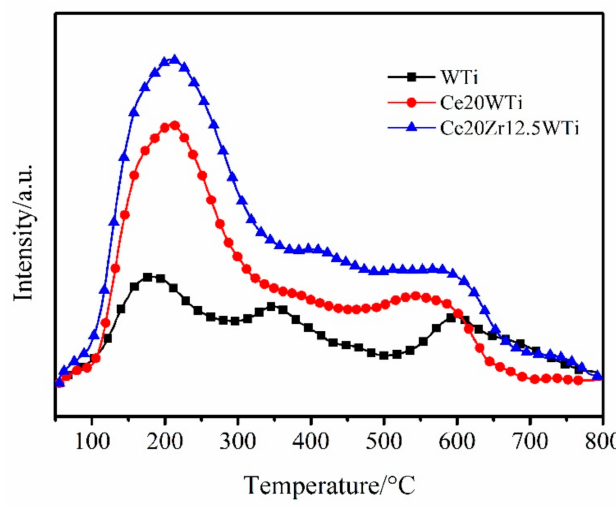
Figure 7. NH 3 -TPD profiles of Ce x Zr y WTi